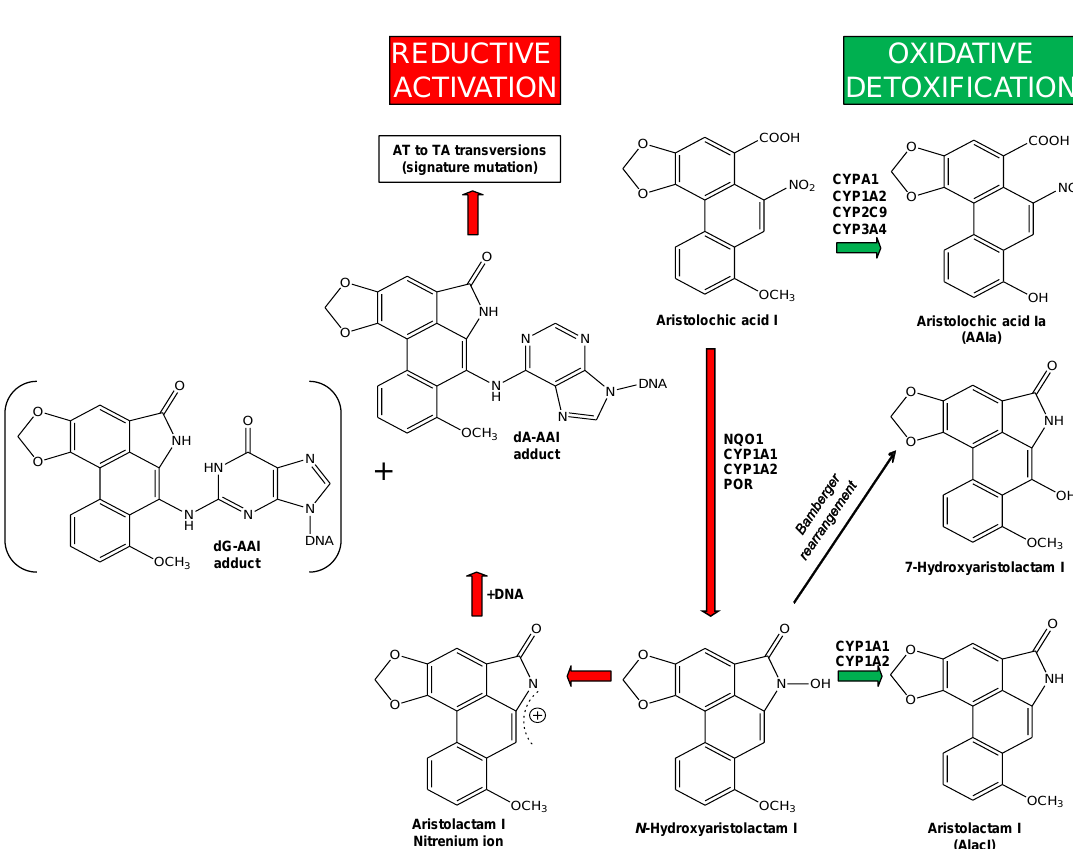
Figure 3. Activation and detoxification pathways of AAI. dA-AAI, 7-(deoxyadenosin- N 6 -yl)aristolactam I; dG-AAI, 7-(deoxyguanosin- N 2 -yl)aristolactam I; CYP, cytochrome P450; NQO1, NAD(P)H:quinone oxidoreductase; POR, NADPH:CYP oxidoreductase.